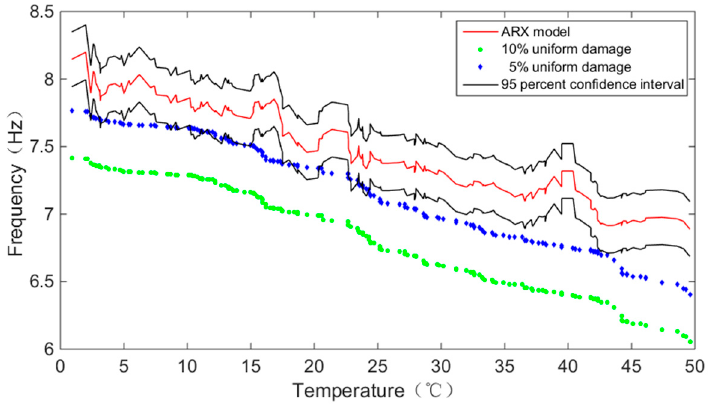
Figure 14. Frequencies of the slab vs. temperature based on ARX model, 10% uniform damage, 5% uniform damage and the 95 percent confidence